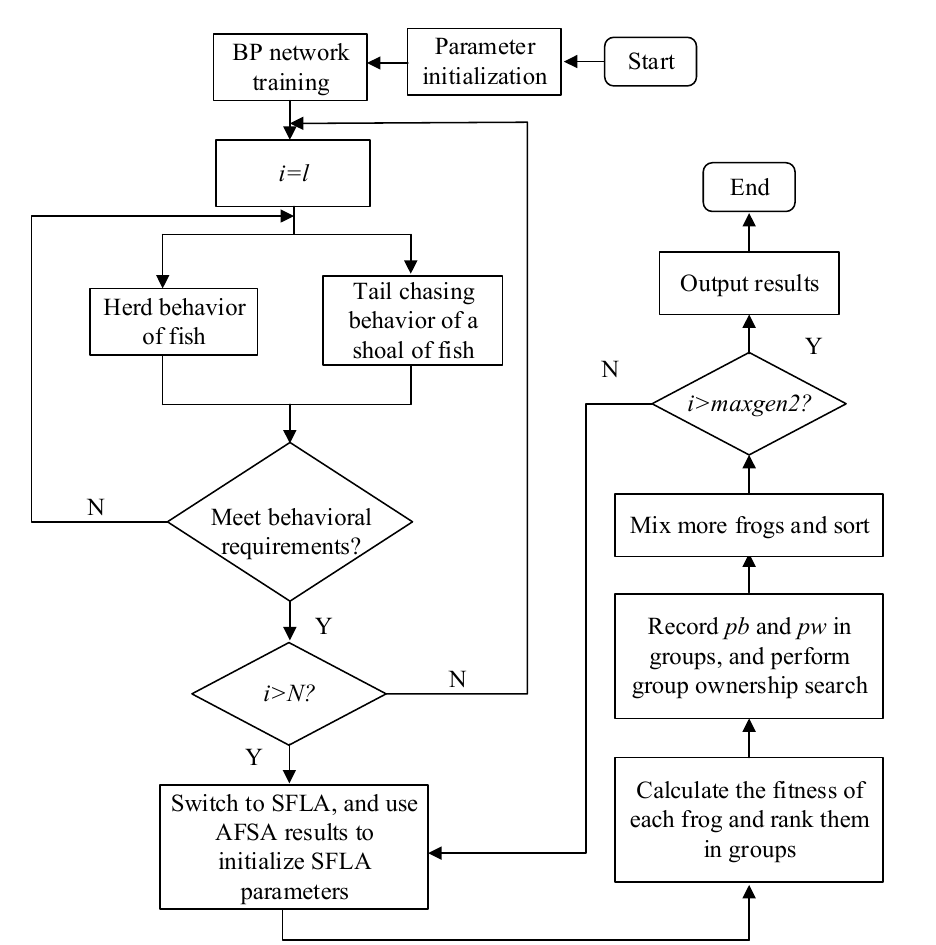
Figure 4. Schematic diagram of AFS-SFLA